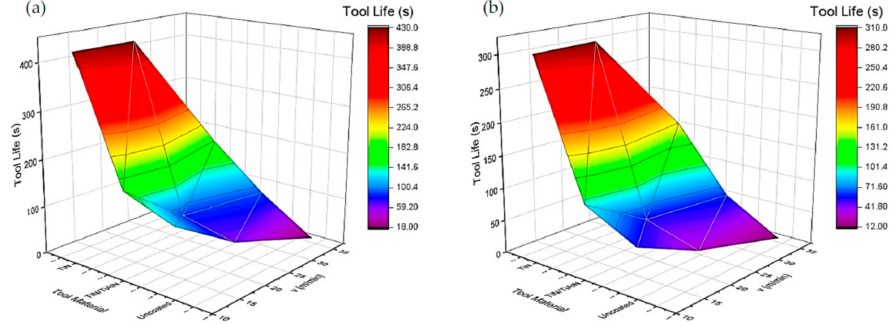
Figure 1. Estimated response surface of tool life versus tool material and cutting speed for ( a ) AISI 304 and ( b ) AISI 2205 stainless